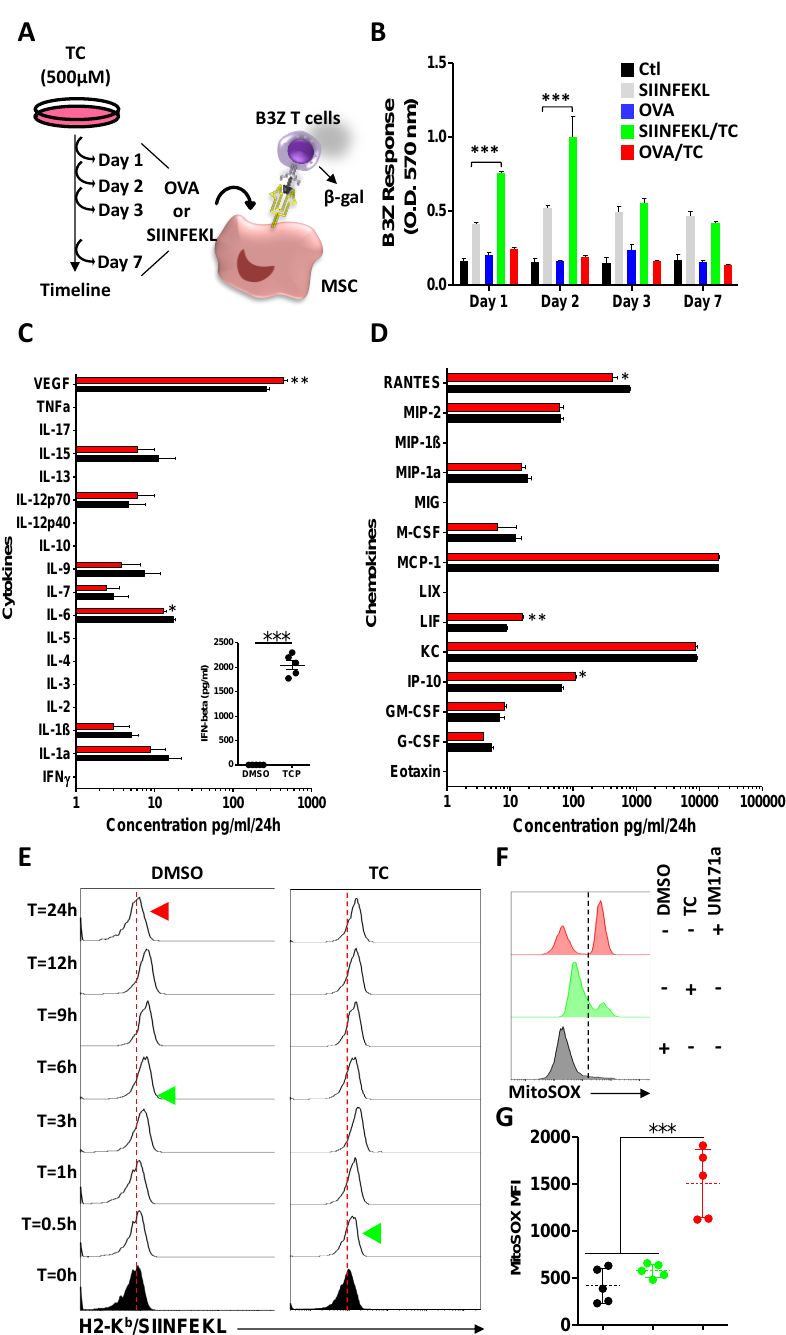
Figure 4. TC enhances the immunogenicity of MSCs. ( A ) Schematic diagram demonstrating the experimental design used for the antigen presentation assay. ( B ) B3Z activation in response to DMSO-treated MSCs (black), SIINFEKL-pulsed DMSO-treated MSCs (light gray), OVA-pulsed DMSO-treated MSCs (blue), SIINFEKL-pulsed TC-treated MSCs (green), and OVA-pulsed TC-treated MSCs (red). For this experiment, n = 6/group with *** p < 0.01. ( C , D ) Secretome analysis depicting cytokines ( C ), and chemokines ( D ) in response to DMSO (black) or TC (red) treatments. For these two experiments, n = 6/group with * p < 0.05 and ** p < 0.01. ( E ) Representative flow-cytometry experiments evaluating the stability of the SIINFEKL:H2-K b complex over time in response to DMSO (left panel) and TC (right panel) treatments. ( F , G ) Representative flow-cytometry analysis assessing the ROS levels in the mitochondria ( F ) and its corresponding MFI ( G ) in response to DMSO (black), TC (green), or UM171a (red) treatments. The dotted line in panel F separates negative from positive ROS